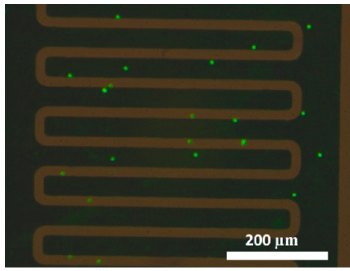
Figure 6. Fluorescence microscopic images illustrate 20 cells of Cryptosporidium bound to the immobilized antibodies on a 1-mm 2 electrode surface area using direct fluorescein isothiocyanate (FITC)-conjugated anti- Cryptosporidium oocysts monoclonal antibodies.